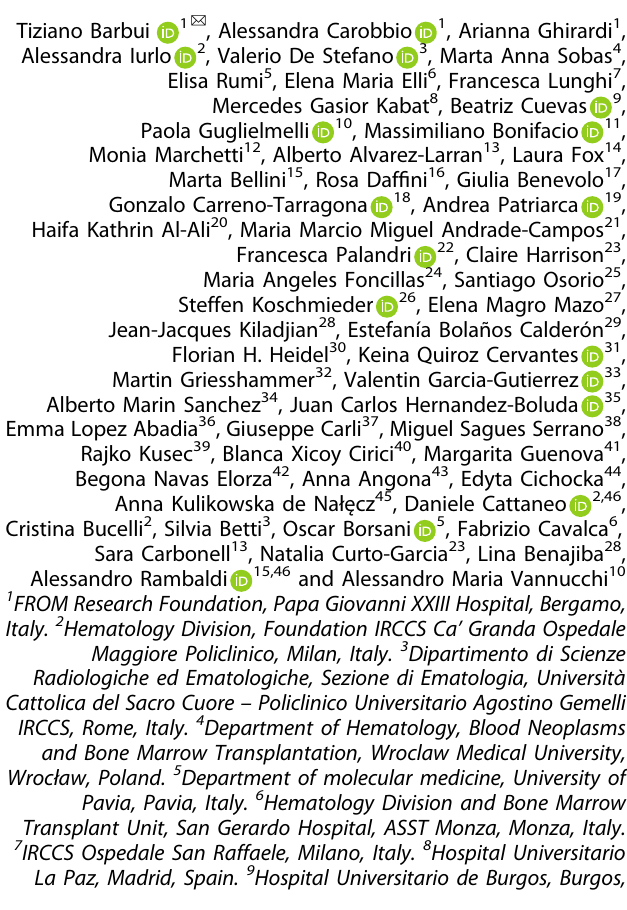
results of the new boosters targeting the newest strains of the omicron variants, we suggest a prompt identi fi cation of the MPN subgroup at high risk of hospitalization, in which early treatment with the recent monoclonal antibodies against the spike protein of the SARS-CoV-2 virus, anti-in fl ammatory and antiviral drugs can be